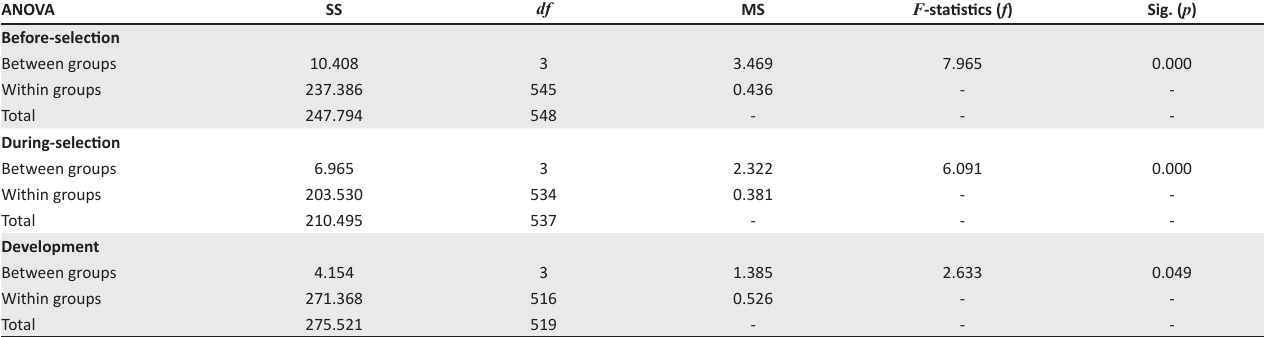
TABLE 3: Analysis of variance comparison between tenure